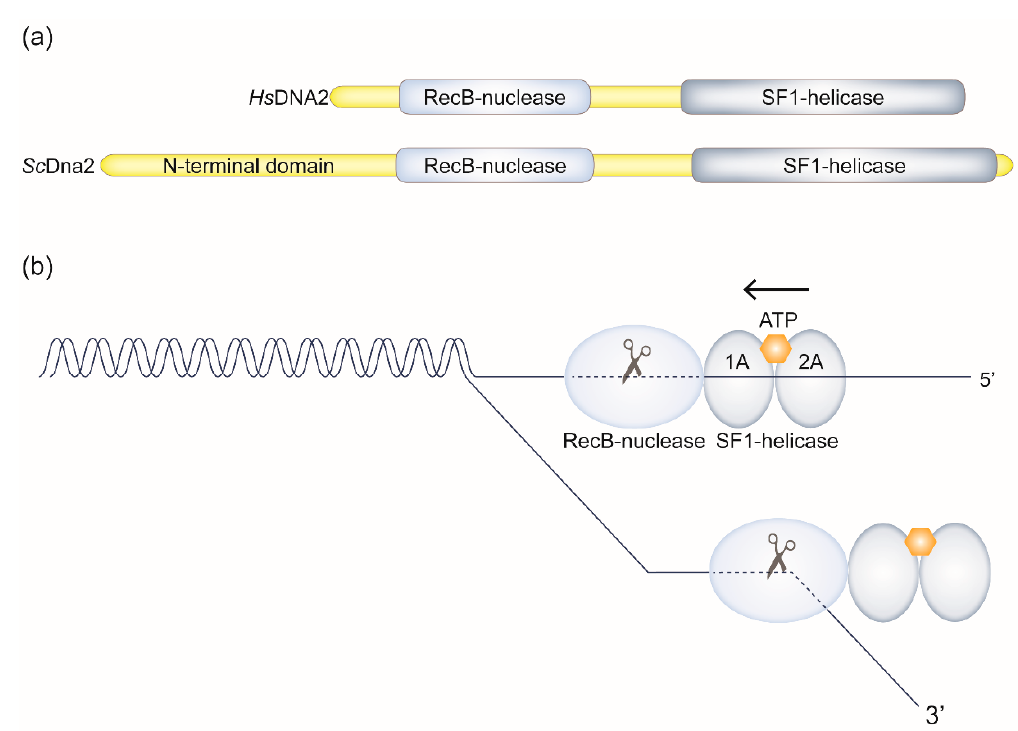
Figure 1. Structure and function of Dna2 DNA2 . ( a ) Across organisms, Dna2 DNA2 comprises a RecB nuclease and superfamily 1 (SF1) helicase domain. The human ( Hs ) protein is 1060 amino acid residues in length, while budding yeast ( Sc ) Dna2 spans 1522 amino acids with an additional N-terminal domain, which is unstructured and serves a redundant role in S phase checkpoint activation [22]. ( b ) A murine DNA2-ADP-ssDNA structure has been solved [23] showing that ssDNA substrates must thread through an internal channel containing the nuclease active site for cleavage (indicated by a scissors symbol). Exiting this channel, a 5 ′ -ended strand may productively engage the SF1 helicase (represented through its subdomains 1A and 2A with the ATP-binding site indicated), which exhibits 5 ′ -to-3 ′ translocation polarity (indicated by an arrow). In this arrangement, DNA cleavage will disrupt further translocation activity such that the actions of the nuclease domain effectively control the extent of ATPase/helicase activity. This is consistent with biochemical analyses, in which the full capacity of the helicase activity of Dna2 DNA2 is only revealed when the nuclease is experimentally inactivated [24,25]. Dna2 DNA2 can also degrade ssDNA from the 3 ′ -end, but it is unclear whether the helicase domain has a role in this. How the actions of the nuclease and helicase domains are coordinated in vivo remains to be fully elucidated, but a close cooperation of their activities in all pathways involving Dna2 DNA2 is highly likely.